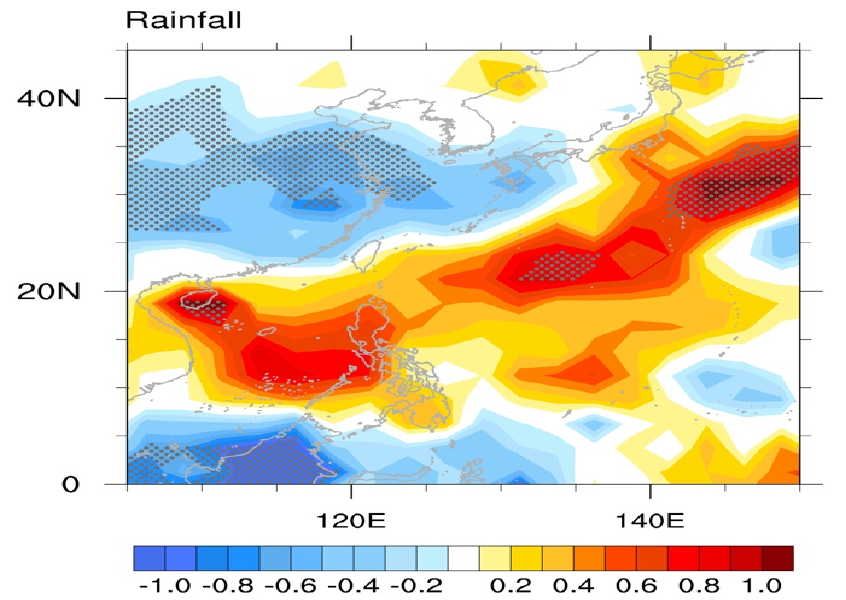
Figure 6. CMAP rainfall (shading, unit: mm day − 1 ) and wind (vectors, unit: m s − 1 ) at 850 hPa in May regressed onto the normalized time series of PC1. Dotted areas indicate that the regression coefficients of rainfall are significant at the 95% confidence level.